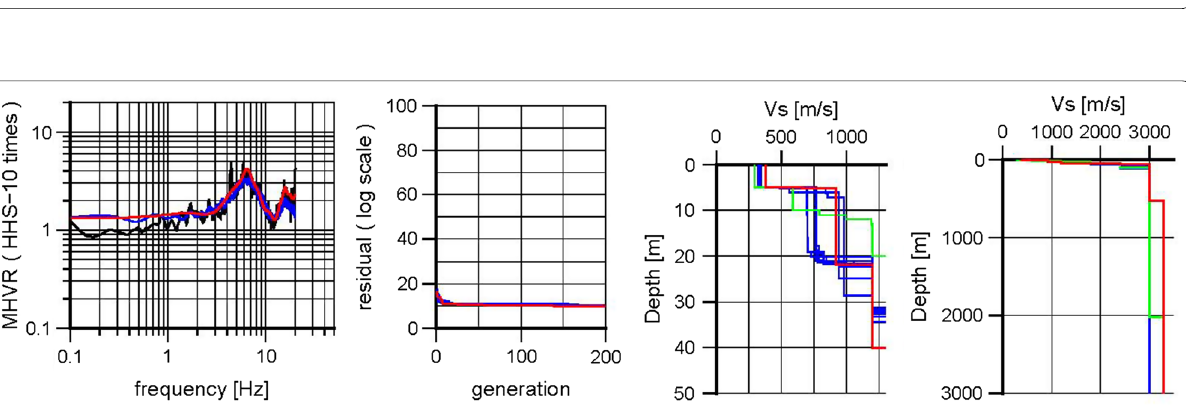
Fig. 16 Best-fit model (red line) in comparison with the observed MHVR (black line) in the left panel, convergence with respect to the generation in the middle panel, and shallow (< 50 m) and deep (< 3 km) parts of the obtained S-wave velocities at EHM012 in the two right panels. Blue lines are those for ten trials with different genes, while red lines are values of the best model. Green lines in the two right panels are S-wave velocities of the initial model. We should note that here we used the formula for earthquake (i.e., Eq. 3), not for